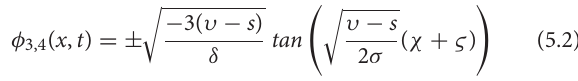
FIGURE 3 | Variation of periodic φ c against χ for β L 0.92. =